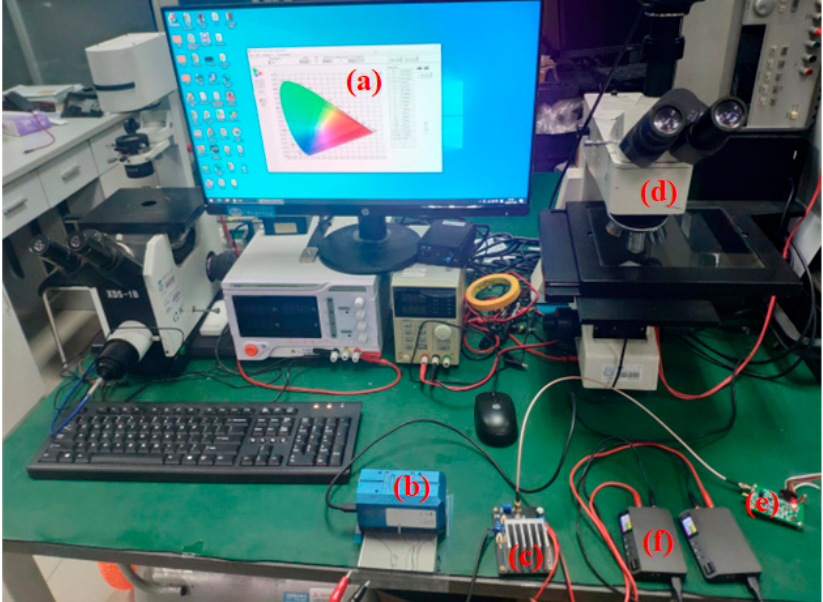
Figure 5. An experimental platform for driving EWDs. ( a ) A computer. ( b ) A colorimeter. ( c ) A power amplifier module. ( d ) A microscope. ( e ) A digital-to-analog conversion module. ( f ) Power supply units.